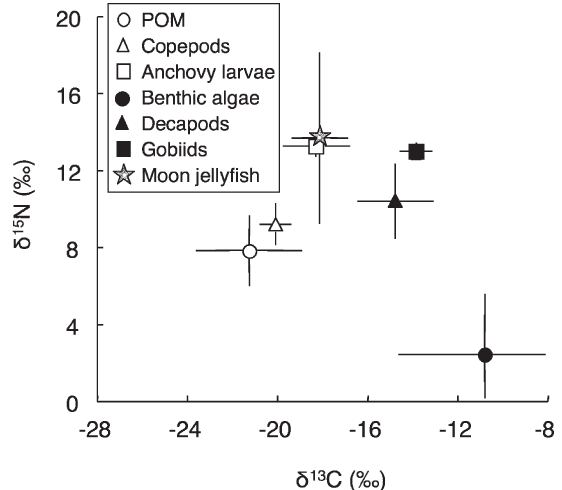
F IG . 5. – Plots of δ 13 C versus δ 15 N for samples collected in Hiroshi- ma Bay in summer 2006. Points are mean values and bars represent standard